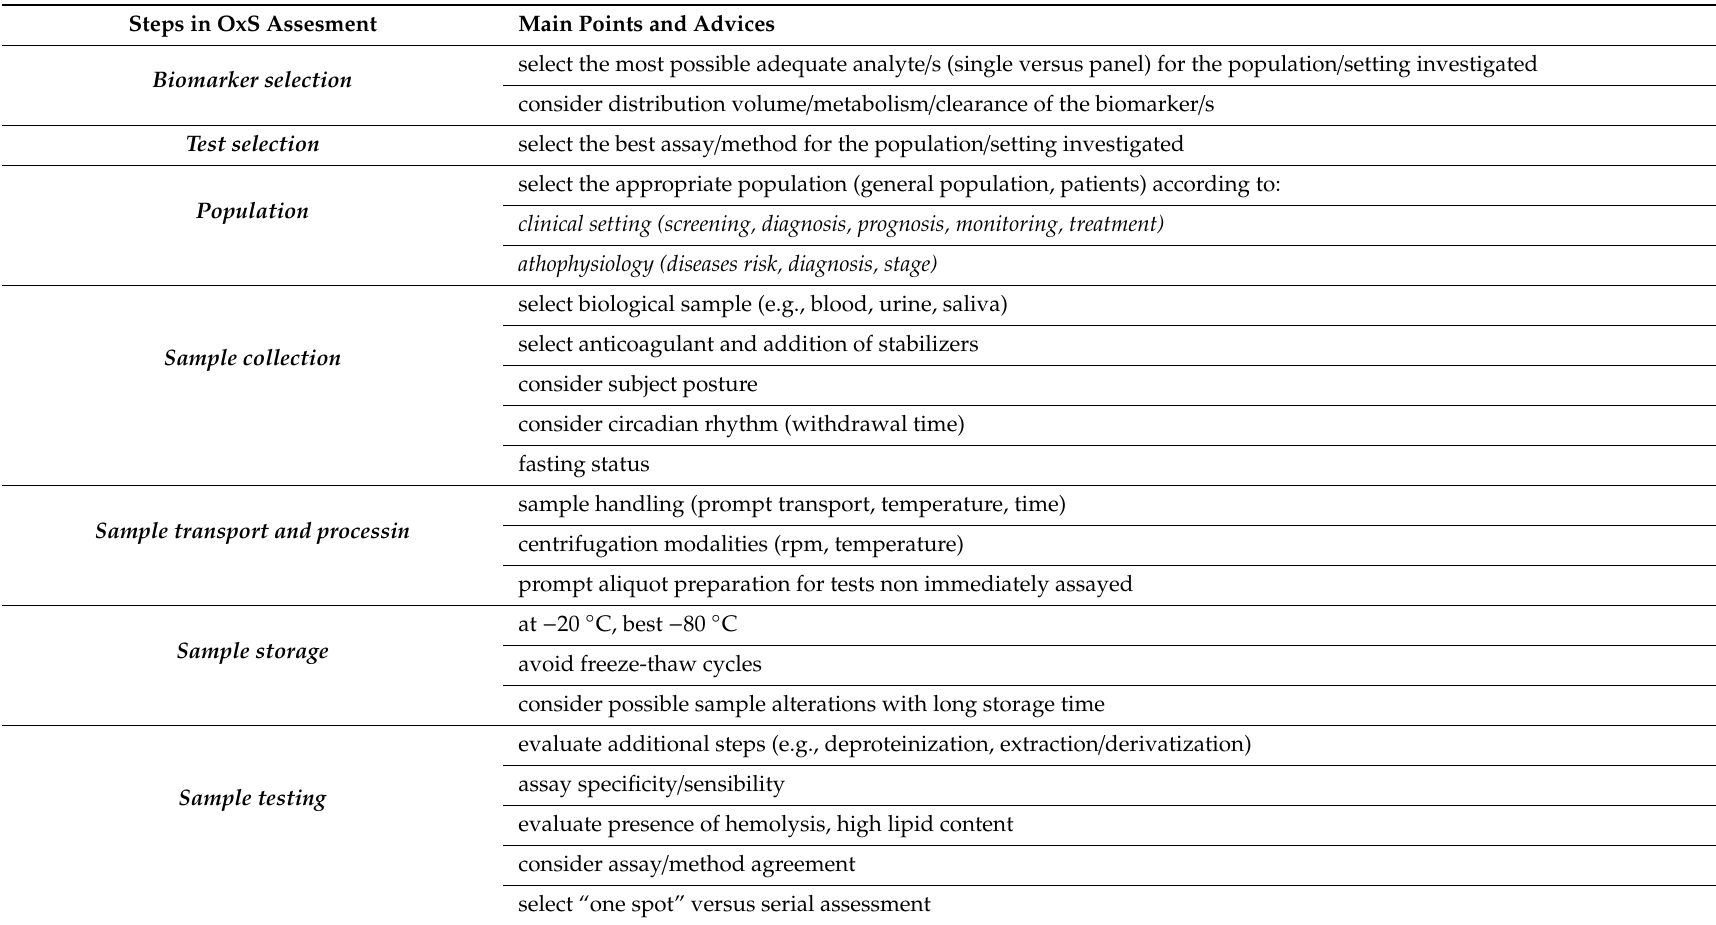
Table 1. Main points to be considered in oxidative stress related assessment and result